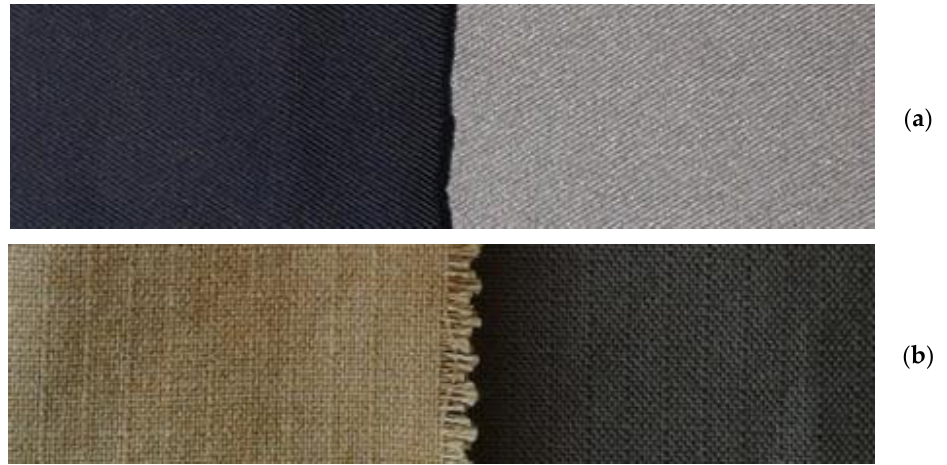
Figure 4. Magnetron sputtering stage: ( a ) linear magnetron (1—Si-Ti sinters, 2—fixtures for fixing sinters); ( b ) vacuum station.